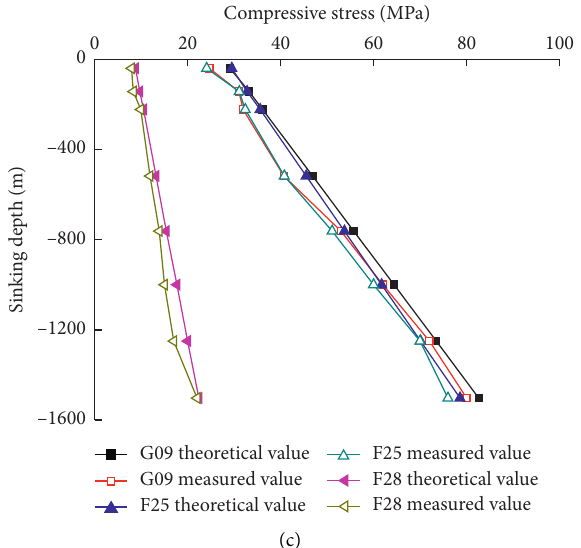
Figure 12: Comparison between measured values and theoretical values. (a) Upper members. (b) Middle members. (c) Lower members.